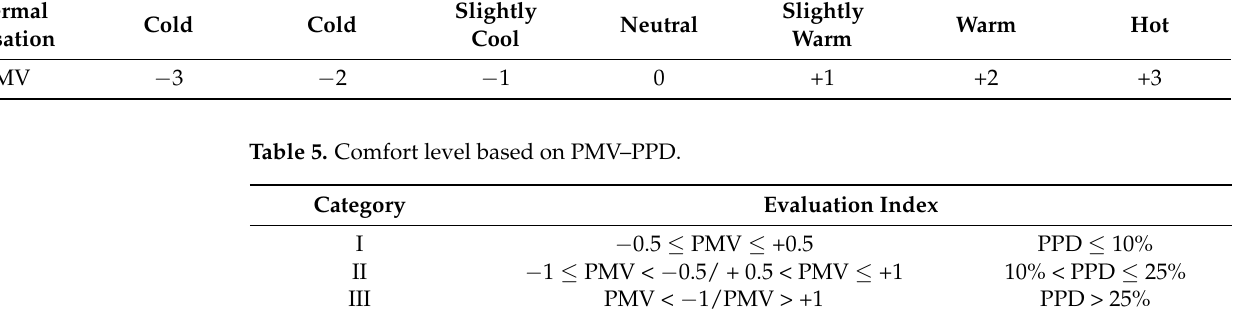
Table 4. Corresponding relation between PMV values and the seven-point thermal index.